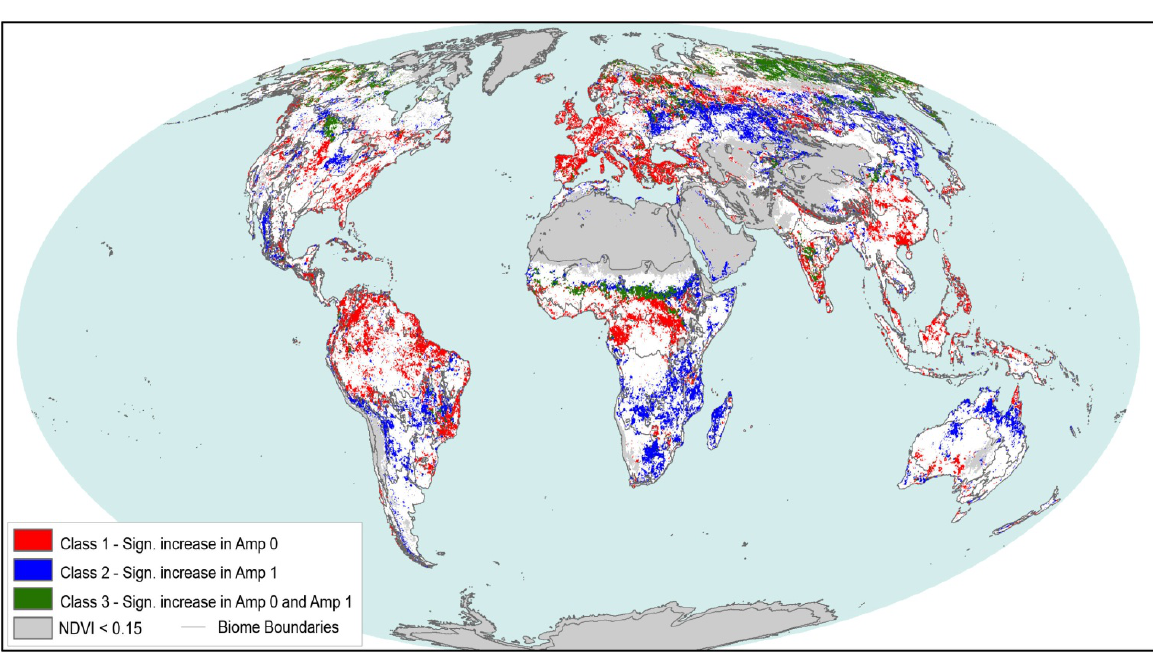
Figure 2. The three most prevalent classes of significant seasonal trends in NDVI: Class 1 (red) shows significant increases in Amplitude 0 (Mean NDVI); Class 2 (blue) shows significant increases in Amplitude 1 (increase in the difference between minimum and maximum NDVI without affecting the mean); Class 3 (green) shows significant increases in Amplitude 0 and Amplitude 1